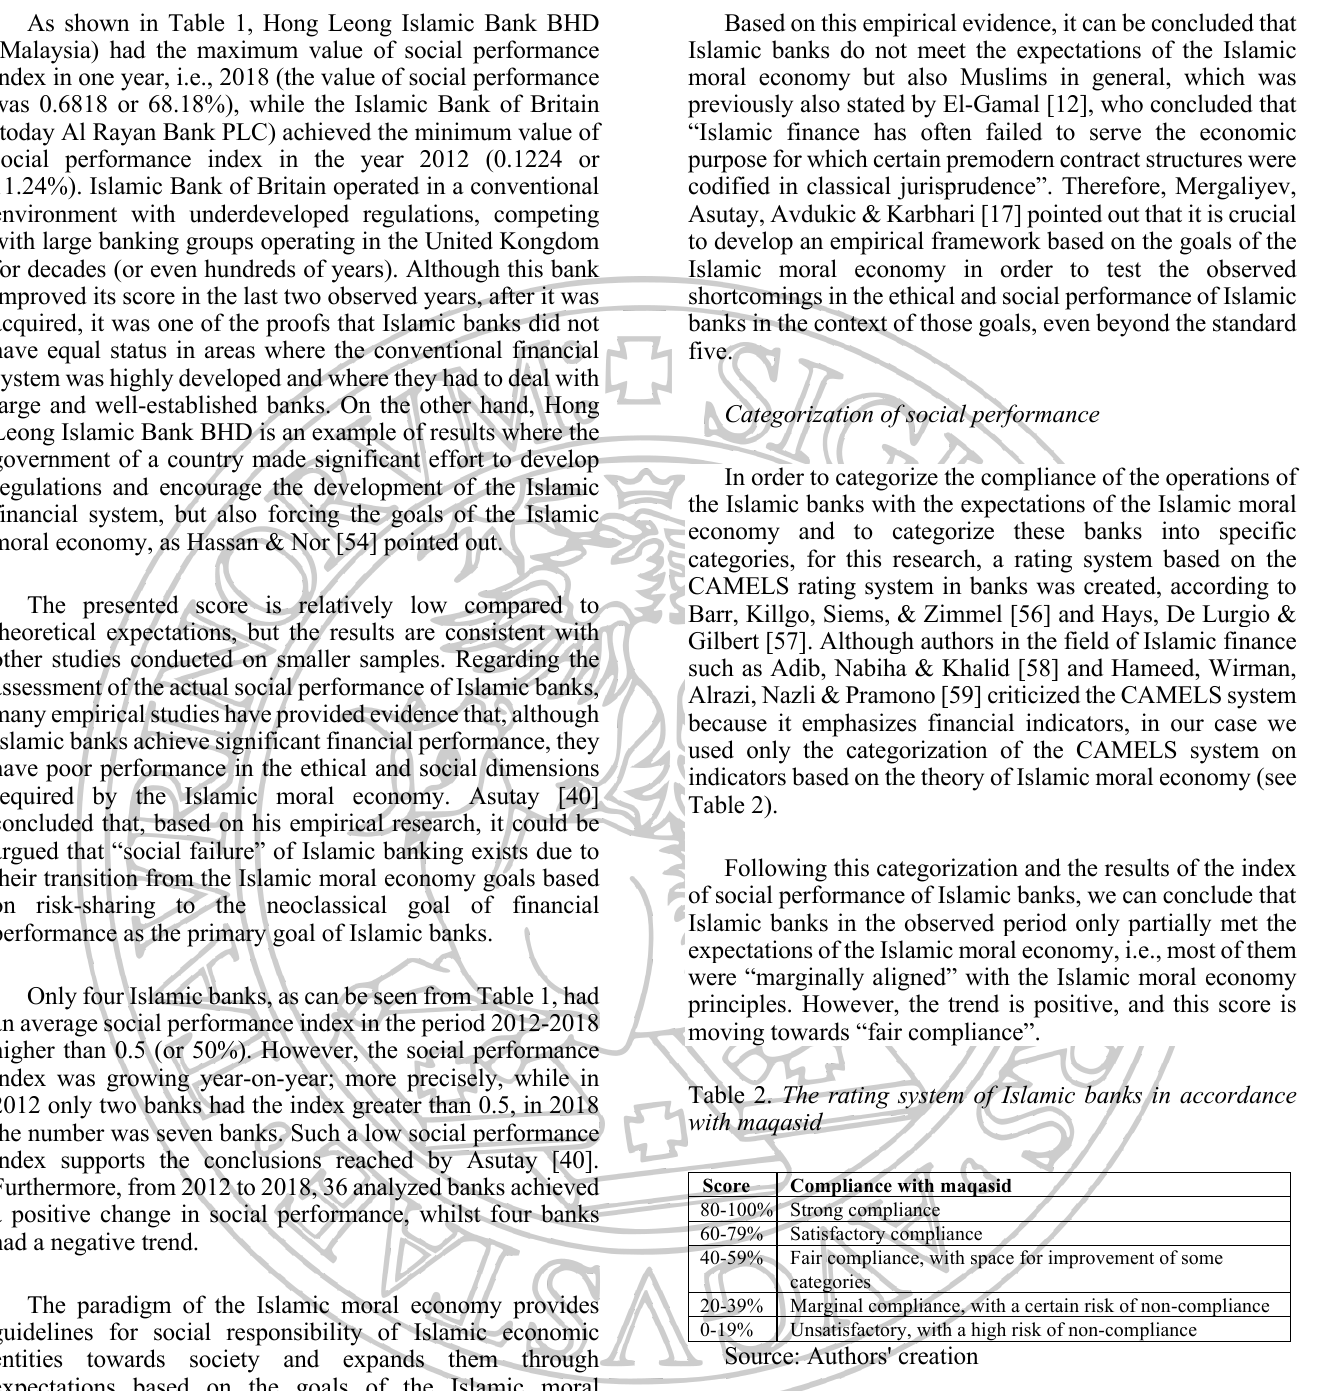
Table 2. The rating system of Islamic banks in accordance with